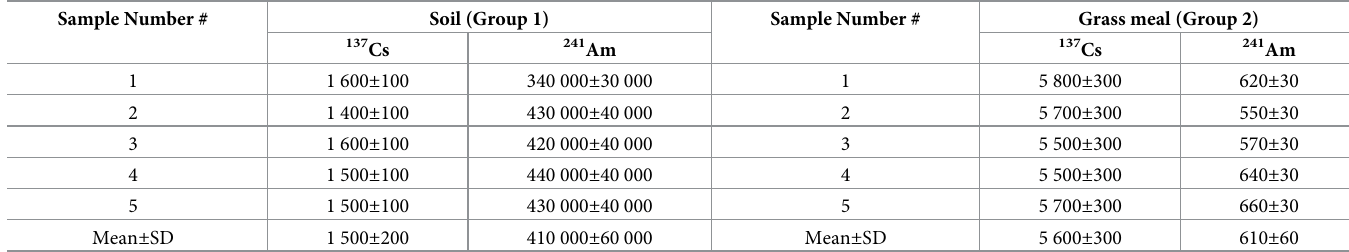
Table 2. Mean radionuclide activity concentration in soil and grass meal offered to the broilers during the experiment, Bq kg -1 DM.